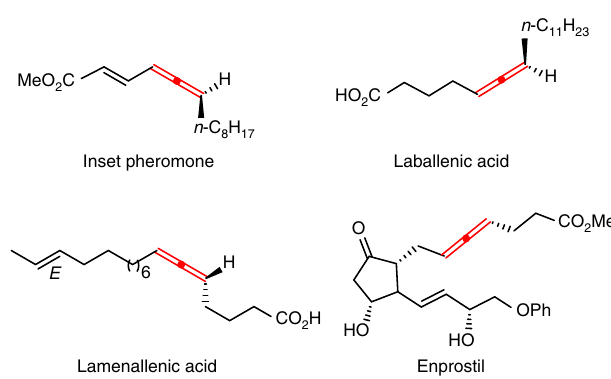
Fig. 1 Representative 1,3-disubstituted allenes. Natural products and a drug